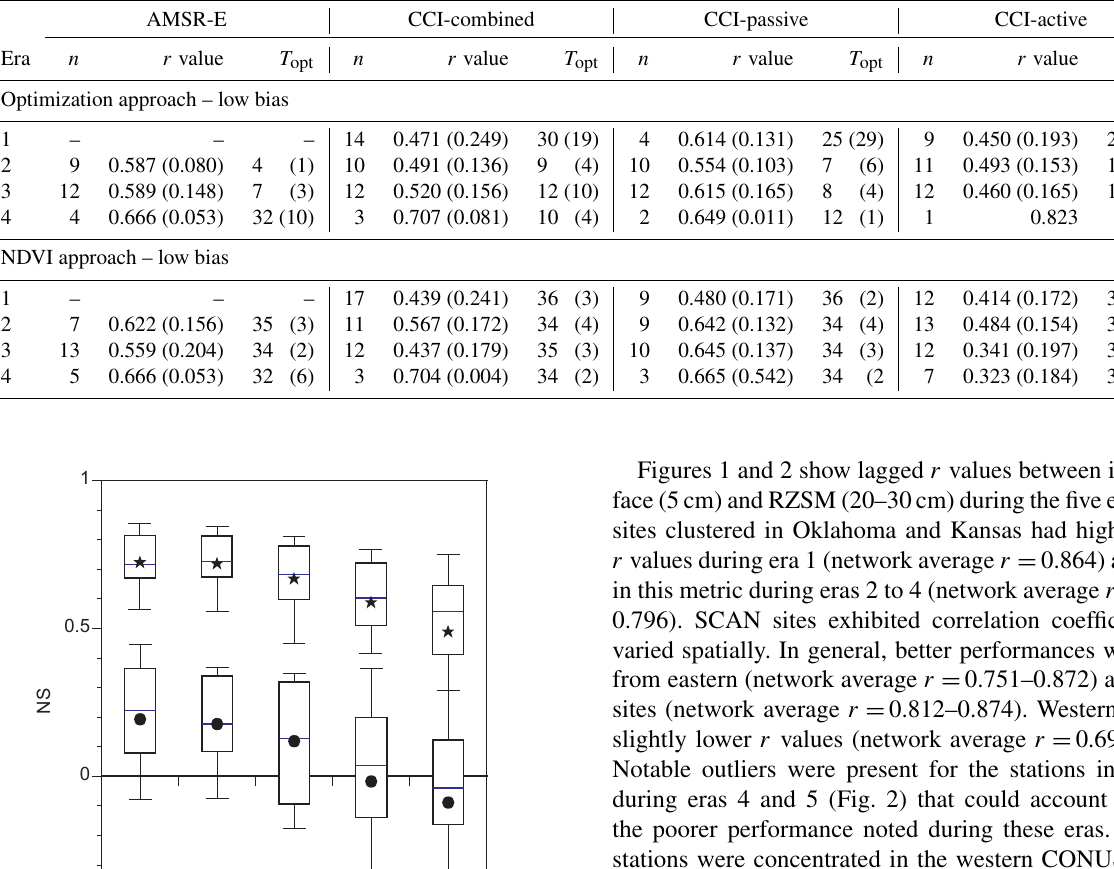
Table 3. Average lagged r values and T opt between SWI based and in situ soil moisture at the 25cm depth for the ARM network. Standard derivation is indicated in parentheses. The n value represents the number of observations.